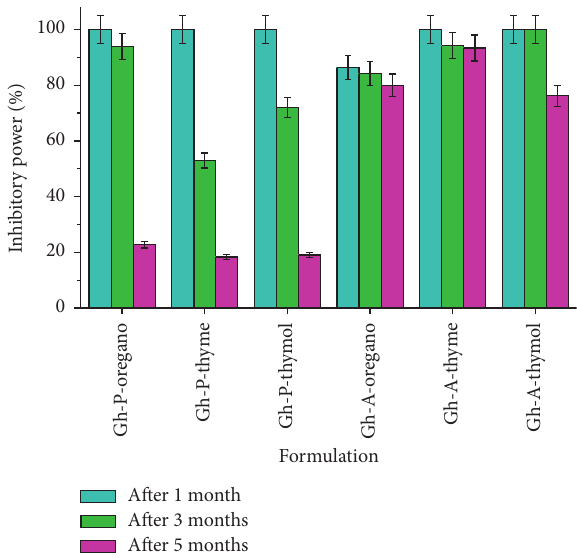
Figure 3: The inhibitory power of